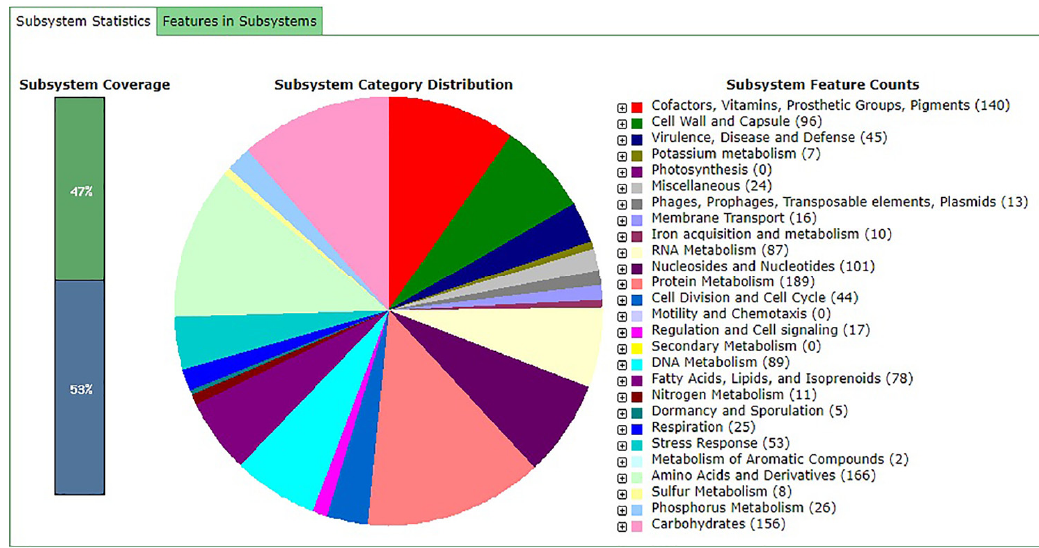
Figure 1. Categories of subsystems of the L. fermentum ATCC 23271 genome annotated by RAST. The genome of L. fermentum ATCC 23271 was compared with the whole genomes of other L. fermentum strains in GenBank using the OrthoVenn web platform. The species formed 2183 gene clusters, of which 1262 belonged to at least two species and 921 pre- sented themselves in a single copy. It was also observed that L. fermentum ATCC 23271 shares 941 orthological clusters with all the other tested strains, and that it has 13 exclusive gene clusters (Figure 2). The 941 shared clusters involved a total of 5704 proteins with each strain coding for approximately 16% of these proteins (Figure 3). Most proteins of these 941 clusters were found to be involved in the biological pro- cesses of chemical reactions and their pathways and cell division processes (Figure 4). With regard to molecular functions, 13.8% of the identified proteins are involved in hydrolase activity, 12.7% are related to a biochemical activity or are components of a larger process and 10% were responsible for the transport of substances inside, outside and between cells (Figure 5). The third group of proteins is related to the cellular components. In this group, most of the proteins comprised cell compartments (Figure 6). Using the reference genomes and other sequences available in the TYGS database, a phylogenetic tree was constructed (Figure 7). Phylogenetic tree analysis showed that the ATCC 23271 strain was the first species to appear during the evolutionary process. Oeno- coccus alcoholitolerans CBAS 474 was used as the outgroup and, therefore, the most distant on the evolutionary scale among all analyzed species and strains. L. cellobiosus DSM 20055 was also found to be inserted within the clade with other L. fermentum strains. The clade formed by L. fermentum had a 97% confidence level. L. fermentum ATCC 23271 was found to be more closely related to L. cellobiosus DSM 20055, within the clade, whereas the nearest outside species of the clade was L. gorillae KZ01.